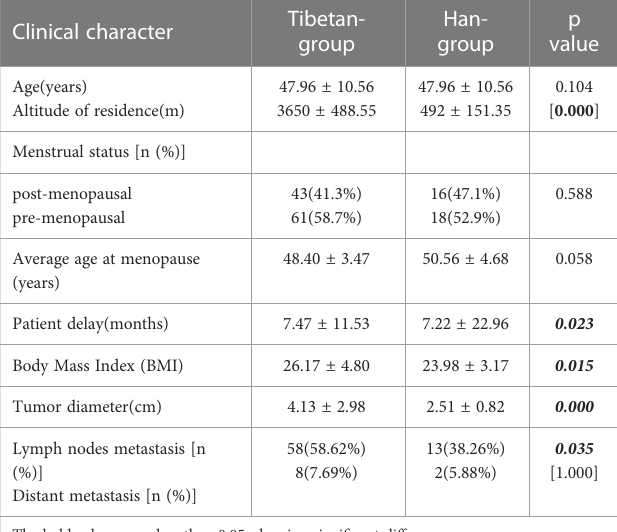
TABLE 1 Clinical characteristics in Tibetan-group and